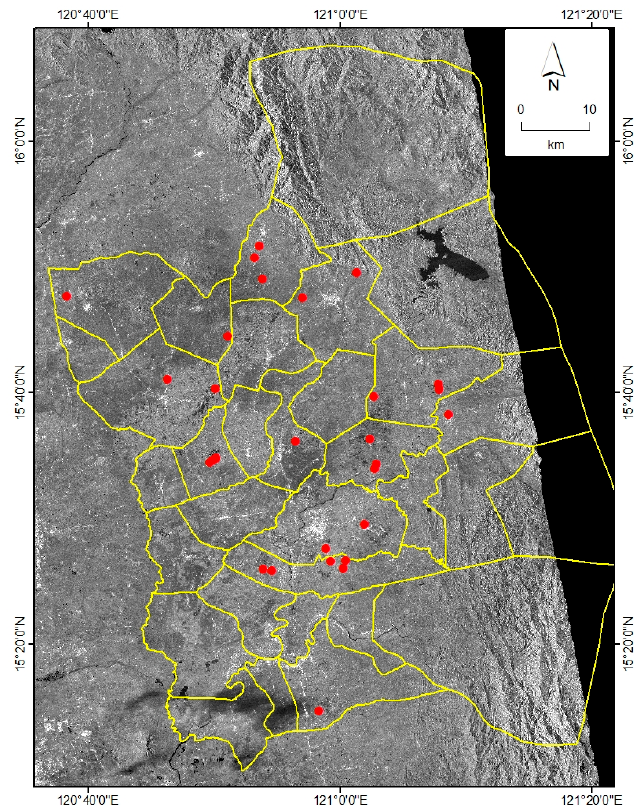
Figure 1. TSX ScanSAR image acquired on 25 May 2013 with 30 monitored sites (red dots) in Nueva Ecija during the WS 2013. The yellow lines are the boundaries of municipalities of Nueva Ecija from the GADM database of Global Administrative Areas [32].